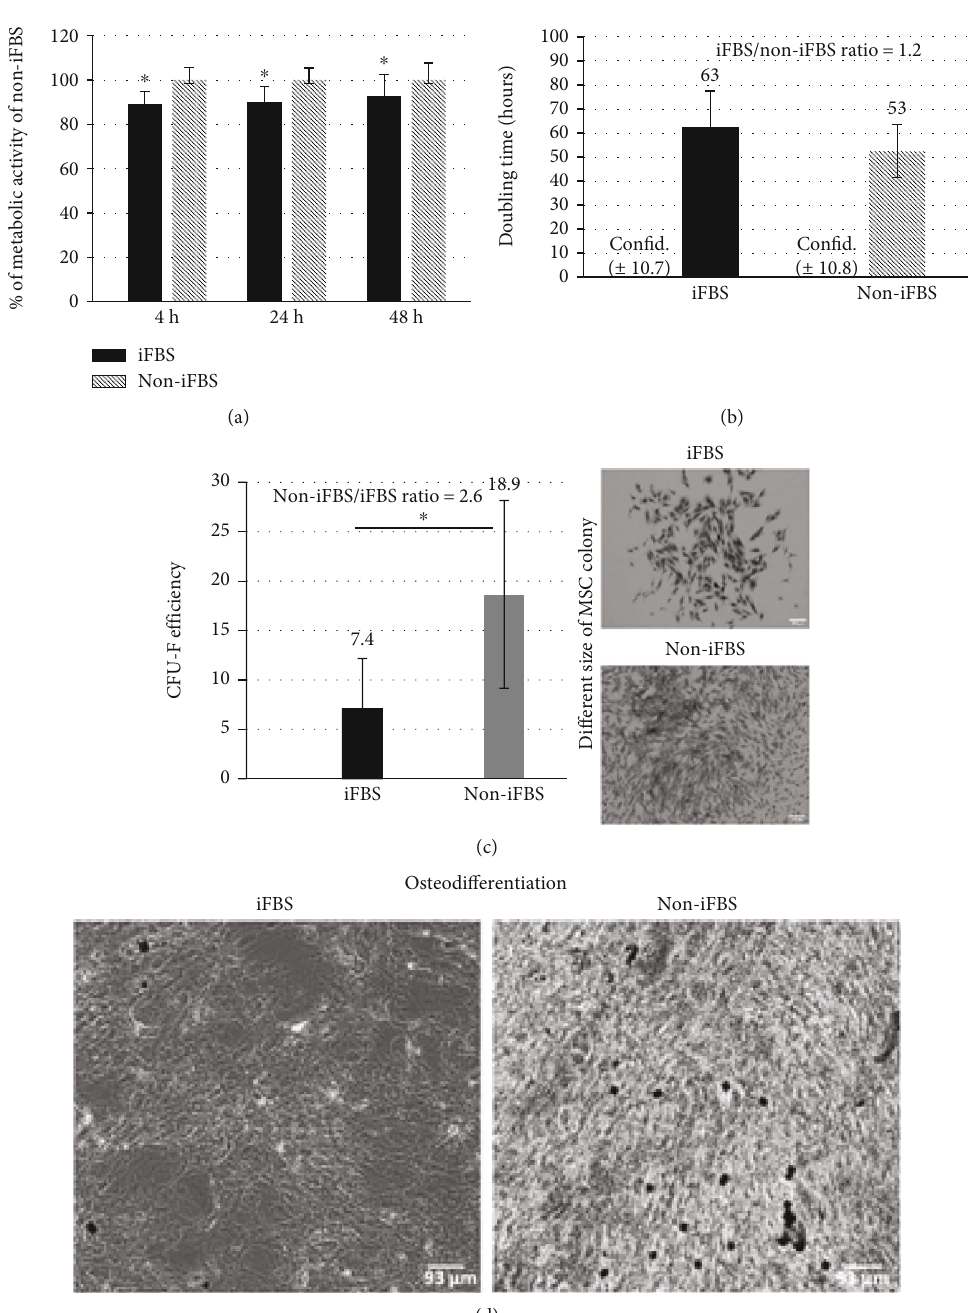
Figure 2: In fl uence of di ff erently treated FBS on MSC behaviour. Analyses of hMSCs cultivated in media with heat-inactivated FBS (iFBS) and heat noninactivated FBS (non-iFBS) after 48h of cultivation (a, b) or 14 days (c) or 21 days (d): (a) metabolic activity; (b) doubling time; (c) CFU-F and colony morphology (white bars correspond to 232 μ m); (d) osteo-di ff erentiation of hMSCs cultivated in osteo- di ff erentiation media supplemented with iFBS and non-iFBS (used von Kossa staining) ((a) Analysed in 5% iFBS and 5% non-iFBS; (b – d) analysed in 10% iFBS and 10% non-iFBS). Statistical analysis was done by one factor ANOVA ( p < 0 : 05 ) with post hoc Fischer LSD test. ∗ Signi fi cant di ff erence ( p < 0 : 05 ) between iFBS and non-iFBS (95% con fi dence interval was determined to verify the similarity/comparability of samples with a nonsigni fi cant di ff